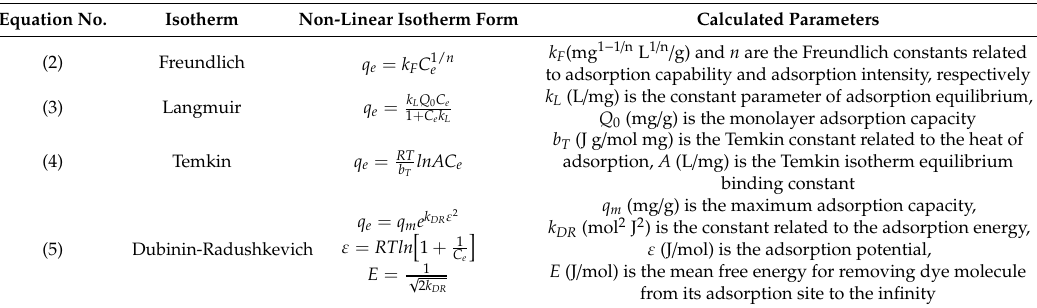
Table 2. Isotherm models applied for fitting of experimental data [20].